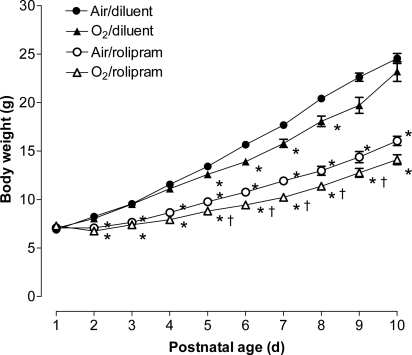
Growth of rat pups exposed to hyperoxia and treated or not with rolipram.Growth curves of rat pups exposed to normoxia or hyperoxia (circles and triangles, respectively), and either treated with rolipram (open symbols) or receiving the diluent alone (littermate controls, closed symbols). Values are mean±sem. Sixteen to 21 rat pups were included on day 0. * Significantly different from air-diluent group; † significantly different from air-rolipram group. Note that except for day 1 and day 2, all values of rolipram-treated pups were significantly lower than those of oxygen-diluent-treated pups.